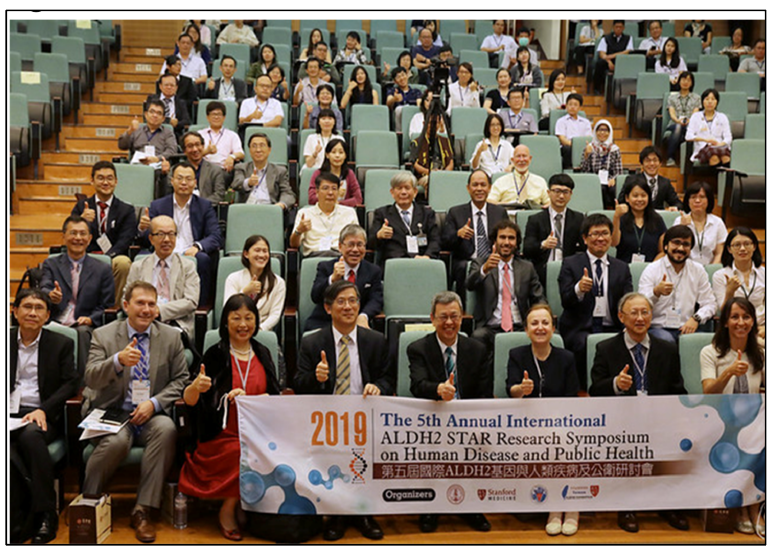
Figure 2. The 5th annual international ALDH2 research symposium on human disease and public health. Group photo on day one of the event.